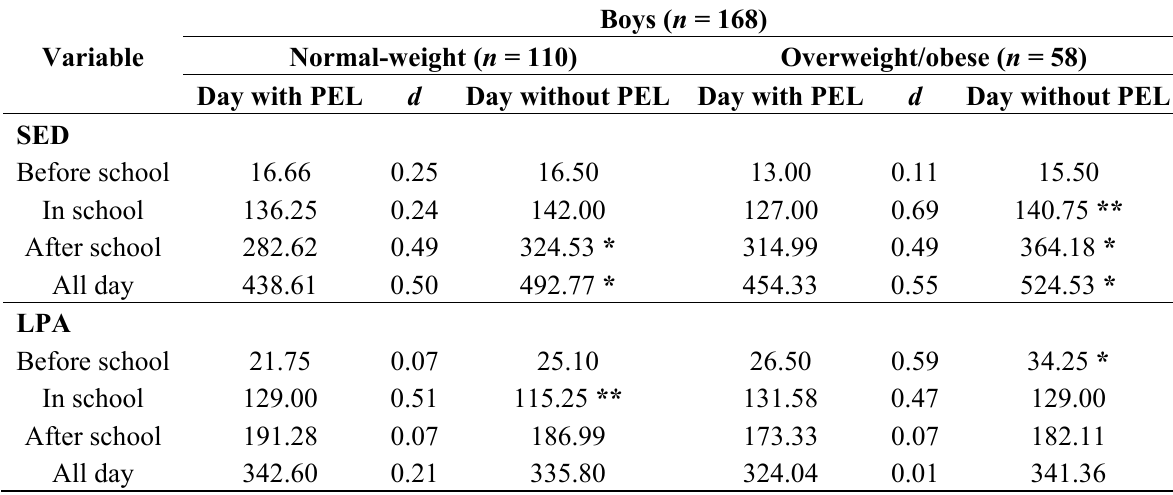
Table 4. Comparison of duration (minutes) of school-day SED, LPA and MVPA (median) in overweight/obese and normal-weight boys between the day with participation in PEL and the day without